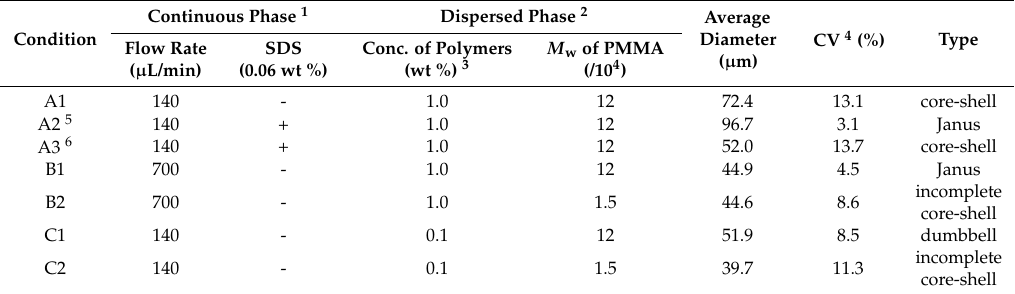
Figure 1. Schematic illustration of procedures to produce microspheres by combining microfluidic emulsification and solvent evaporation. Table 1. Microfluidic conditions for preparation of emulsions, and characteristics of resulting blend